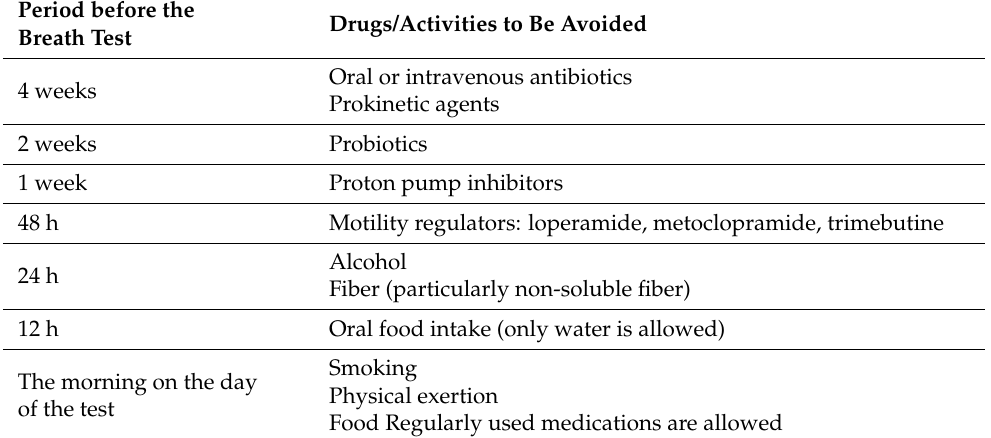
Table 1. Recommended preparation for breath